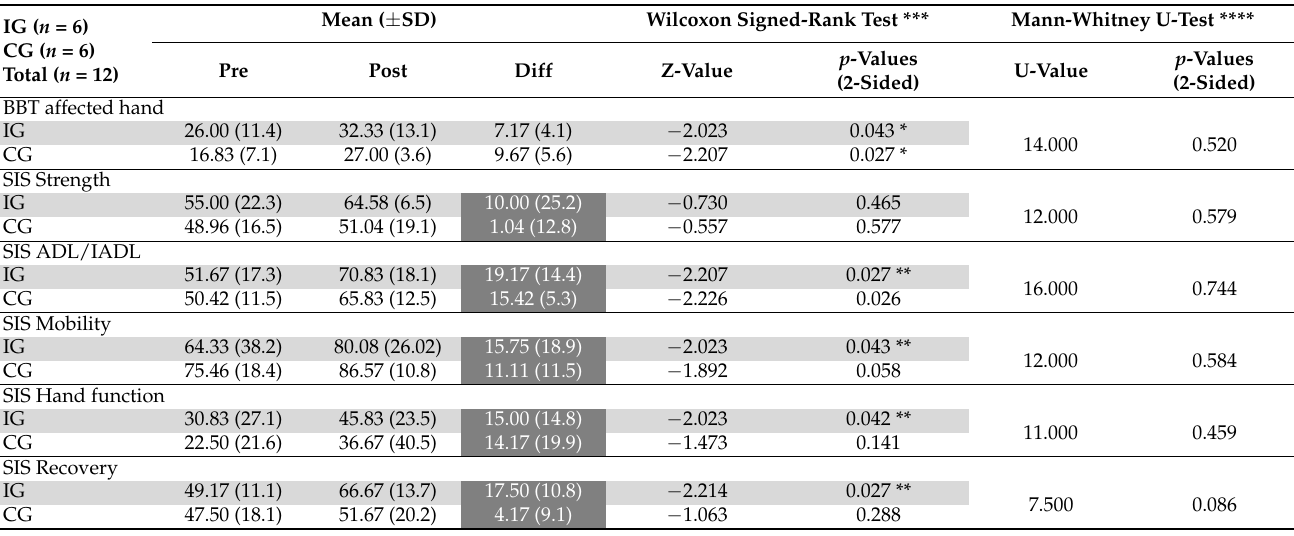
Table 3. Descriptive results (mean ± standard deviation, SD) of the Box and Block Test (BBT) and Stroke Impact Scale